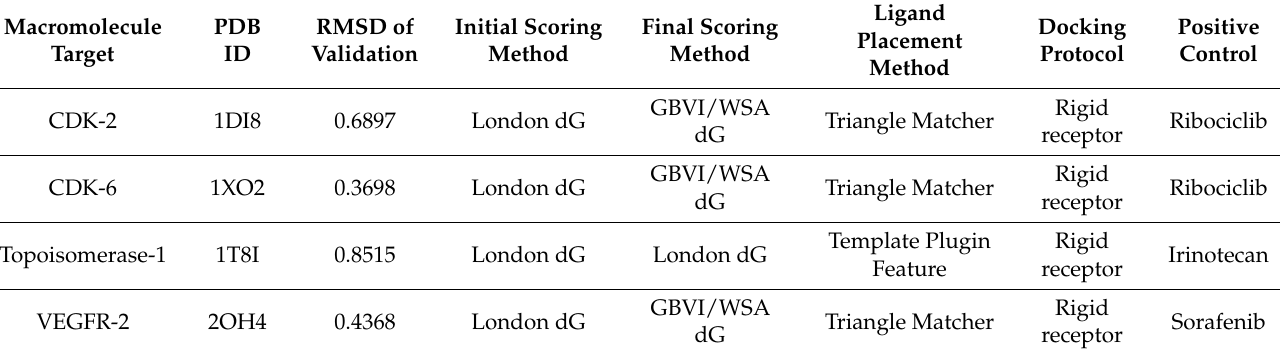
Table 1. Docking protocols for each macromolecule target.